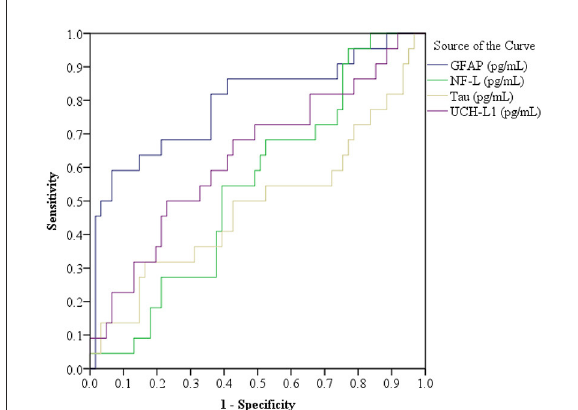
FIGURE4 Receiver operator characteristic curves for the four biomarkers. Glial fibrillary acidic protein (GFAP), in the total sample ( N = 83), area under the curve (AUC) = 0.791, standard error (SE) = 0.063, 95% confidence interval (CI) = 0.669–0.914; Ubiquitin C-terminal hydrolase-L1 (UCH-L1) AUC = 0.633, SE = 0.072, 95% CI = 0.493–0.774; Neurofilament light (NF-L) AUC = 0.544, SE = 0.067, 95% CI = 0.412–0.676; and t-Tau AUC = 0.487, SE = 0.079, 95% CI = 0.331–0.642. n = 83. A subgroup analysis was conducted for patients with Glasgow Coma Scale = 15 (n = 78, CT positive = 20 and normal head CT = 58), as follows: GFAP AUC = 0.776, SE = 0.068, 95% CI = 0.642–0.910; UCH-L1 AUC = 0.633, SE = 0.075, 95% CI = 0.486–0.780; NF-L AUC = 0.508, SE = 0.069, 95% CI = 0.373–0.642; and t-Tau AUC = 0.482, SE = 0.080, 95% CI = 0.325–0.639. Normal Head CT ( n = 58): GFAP Median (Mdn) = 283.59, interquartile range (IQR) = 206.21–441.27; UCH-L1 Mdn = 41.80, IQR = 23.95–83.26; NF-L Mdn = 30.11, IQR = 19.56–54.37; and t-Tau Mdn = 1.79, IQR = 1.20–2.61. Positive Head CT ( n = 20): GFAP Mdn = 787.84, IQR = 351.17–2174.14; UCH-L1 Mdn = 73.71, IQR = 32.83–129.61; NF-L Mdn = 32.70, IQR = 19.67–54.91; and t-Tau Mdn = 1.85, IQR =